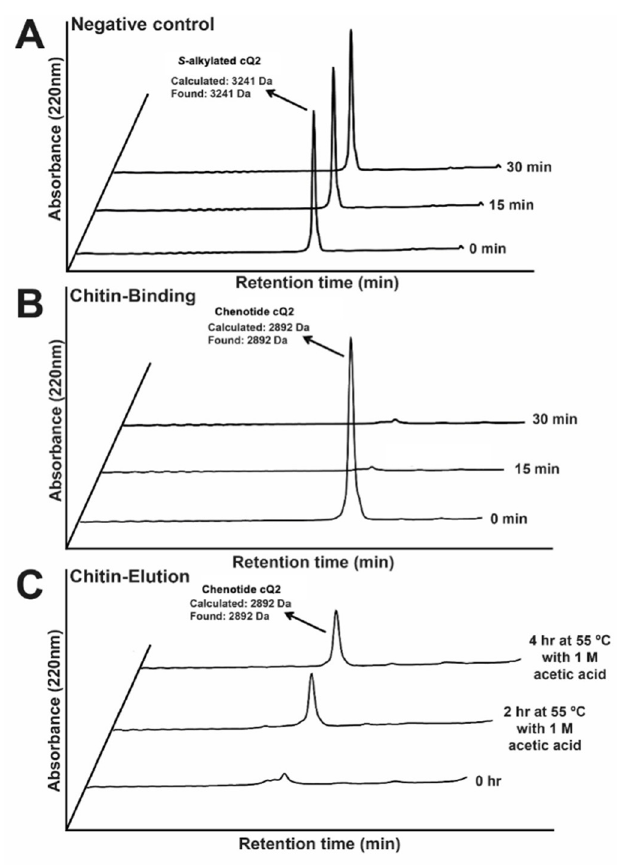
Figure 5. Chenotide cQ2 is chitin binding. Comparison of chitin binding activities of ( A ) chenotide cQ2 and ( B ) S -alkylated cQ2 (iodoacetamido-) using chitin resins. The supernatants were analyzed by RP-HPLC. ( C ) Elution profile of chenotide cQ2 from chitin resin using 1M acetic acid at 55 °C. The supernatants were analyzed by RP-HPLC.